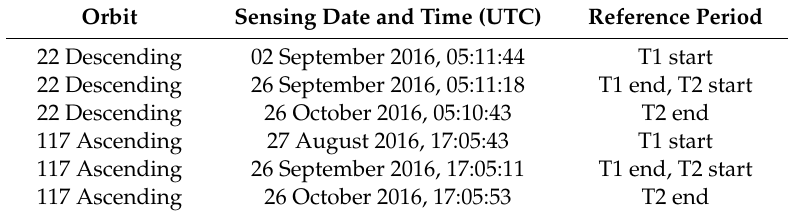
Table 1. Data used in this work and time periods corresponding to the T1 and T2 intervals for each orbit. Orbit Sensing Date and Time (UTC) Reference Period 22 Descending 02 September 2016, 05:11:44 T1